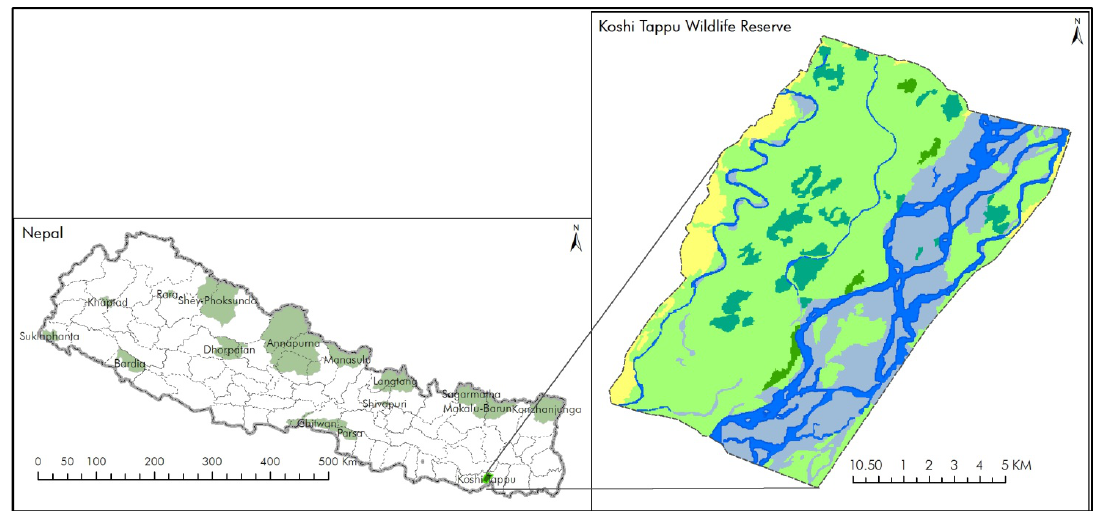
Figure 1. Location of the Koshi Tappu Wildlife Reserve